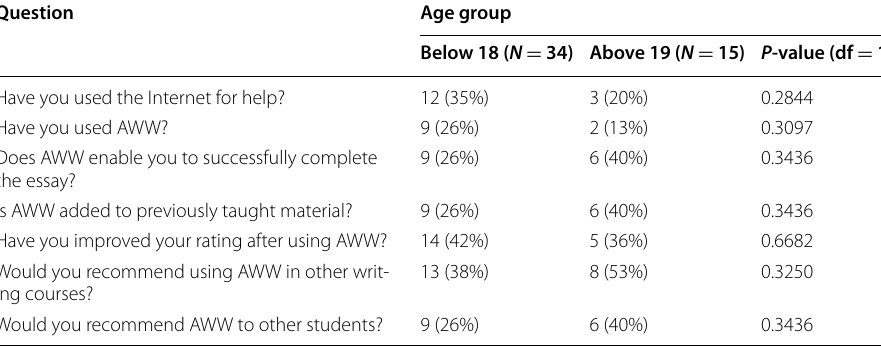
Table 11 Comparison of binary questions by age groups Question Age group